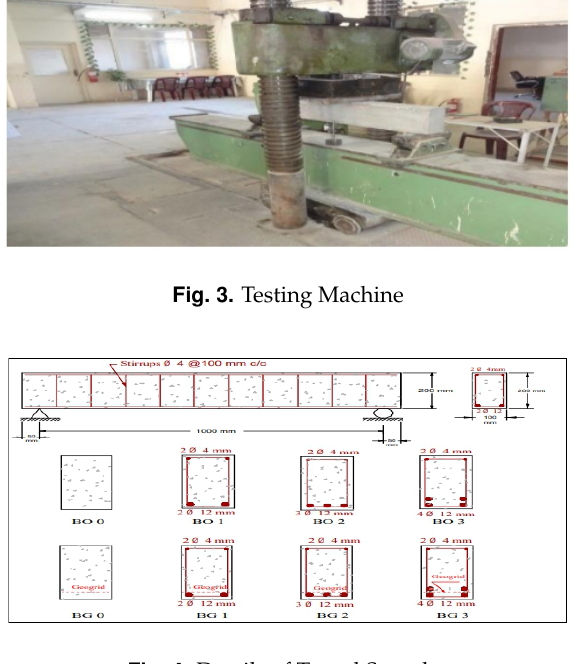
Fig. 4. Details of Tested